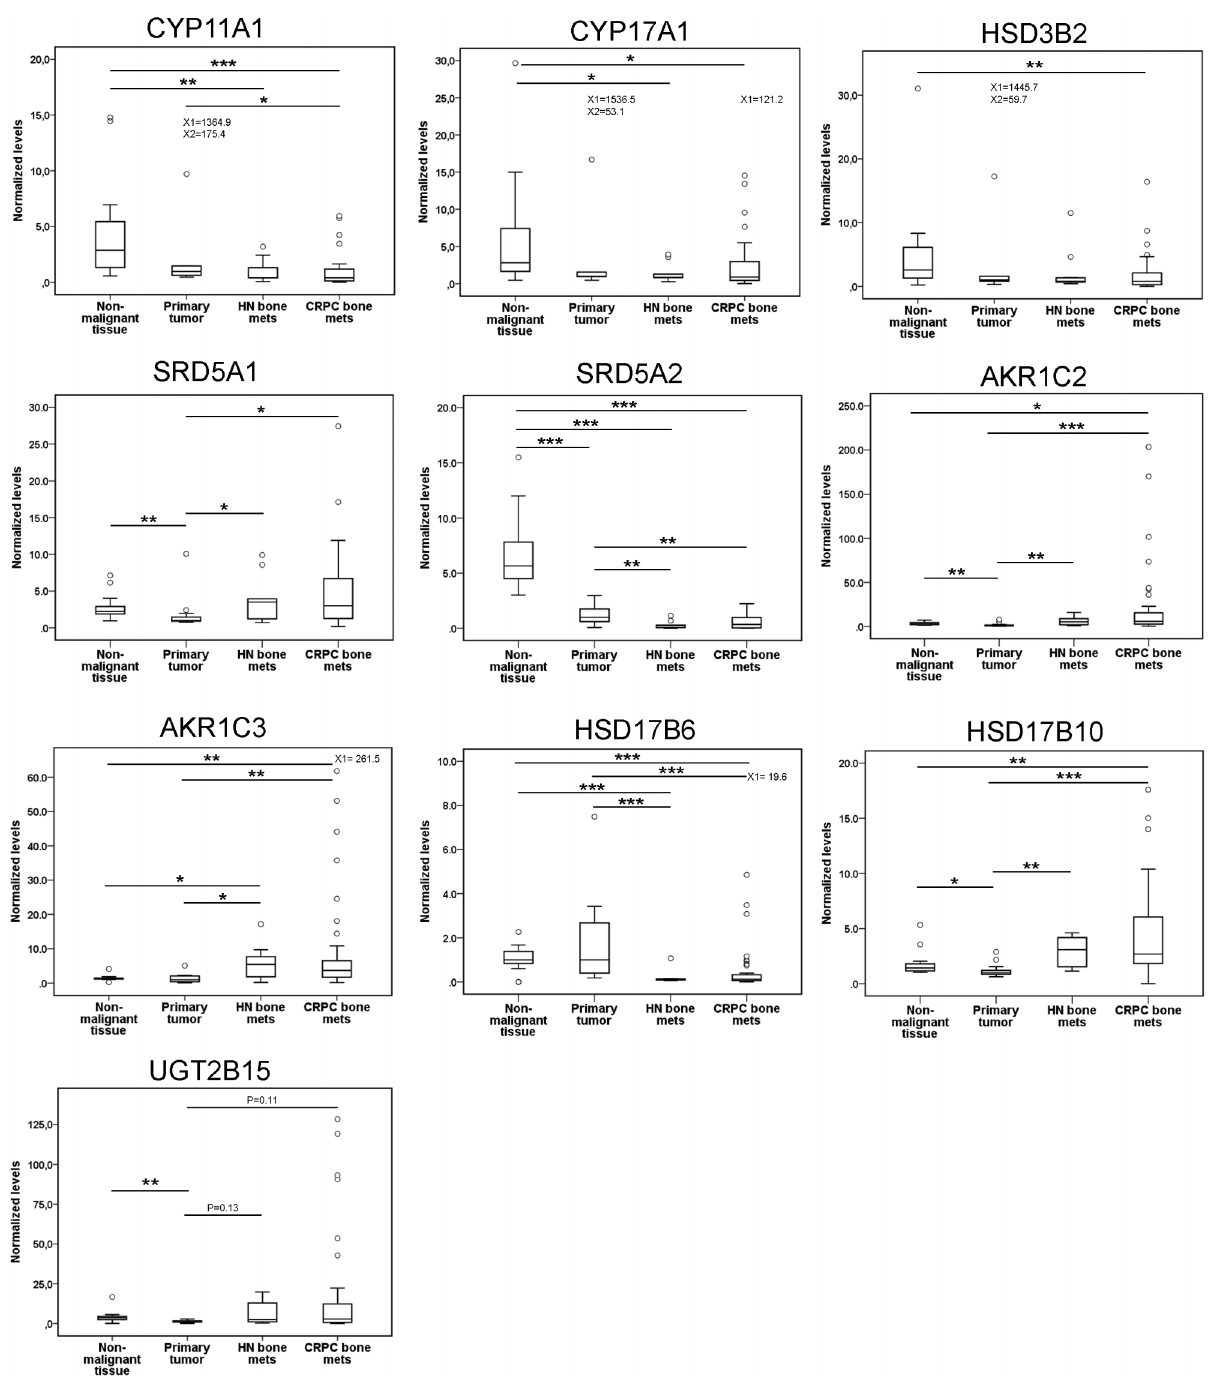
Figure 2. Relative mRNA levels of key enzymes involved in steroid metabolism in non-malignant prostate tissue (n=13), primary prostate tumor tissue (n=13), and in hormone-naı¨ve (HN, n=9) and castration-resistant prostate cancer (CRPC, n=45) bone metastases when quantified with real-time RT-PCR. All mRNA levels were corrected for mRNA levels of the housekeeping gene RPL13A and normalized to the median value of the primary tumor samples. *P , 0.05. ** P , 0.01, *** P , 0.001. Open circles indicate outliers and extremes. X indicates extreme levels outside the scale. doi:10.1371/journal.pone.0077407.g002 obvious that high AKR1C3 protein expression was not directly (60%) samples with low AKR1C3 staining scores ( # 6) showed linked to high AR activity in CRPC metastases; 14 out of 18 (78%) high nuclear AR staining scores ( $ 8, above median, as defined in samples with high AKR1C3 staining scores, defined as an [5], P =0.22). In accordance with previous results [5], high AR AKR1C3 immunostaining score above median (6), and 15/25 immunostaining in the metastases was associated with shorter